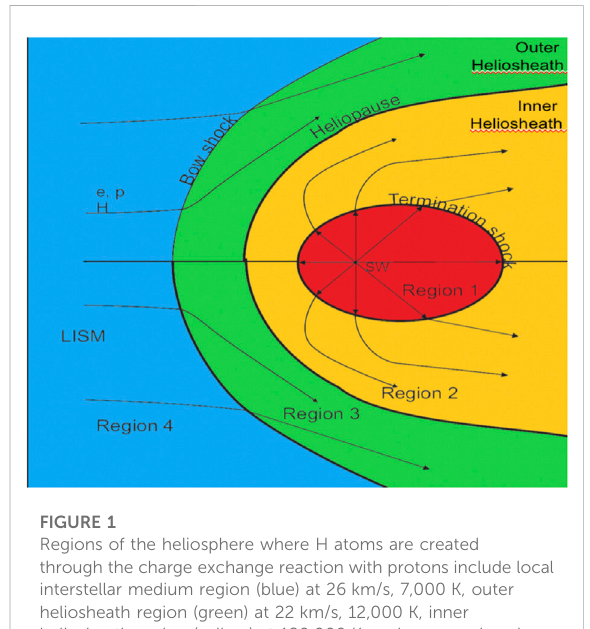
FIGURE 1 Regions of the heliosphere where H atoms are created through the charge exchange reaction with protons include local interstellar medium region (blue) at 26 km/s, 7,000 K, outer heliosheath region (green) at 22 km/s, 12,000 K, inner heliosheath region (yellow) at 180,000 K, and supersonic solar wind region (red) at ~400 km/s (not observable with UV spectroscopy as they are beyond the Doppler width of solar illuminating fl ux). Figure adapted from (Izmodenov,